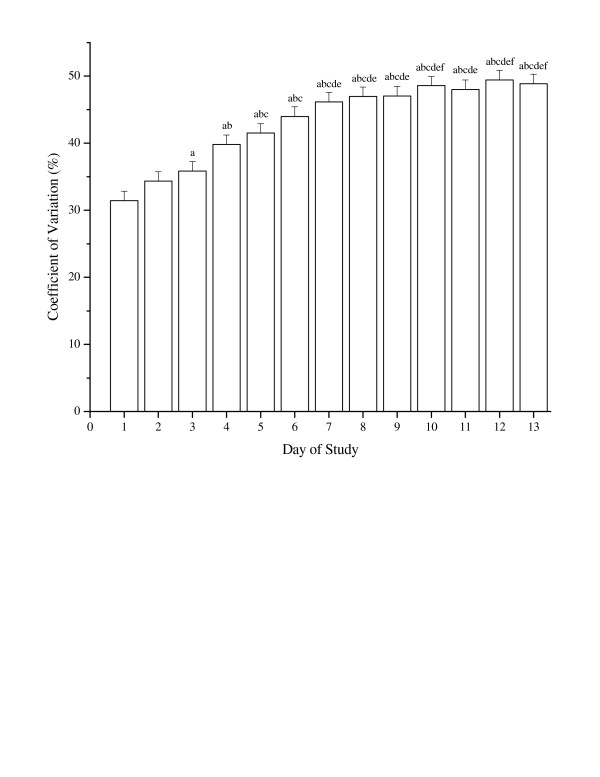
Minute-by-minute activity monitor comparisons (averaged by day) between Actigraph and Actical activity monitors (expressed as a coefficient of variation). a significantly different when compared to Day 1, p < 0.05. b significantly different when compared to Day 2, p < 0.05. csignificantly different when compared to Day 3, p < 0.05. dsignificantly different when compared to Day 4, p < 0.05. esignificantly different when compared to Day 5, p < 0.05. fsignificantly different when compared to Day 6, p < 0.05. Coefficient of Variation (%) = minute-by-minute standard deviation of (AGR - MM) divided by (AGR + MM)/2 times 100.